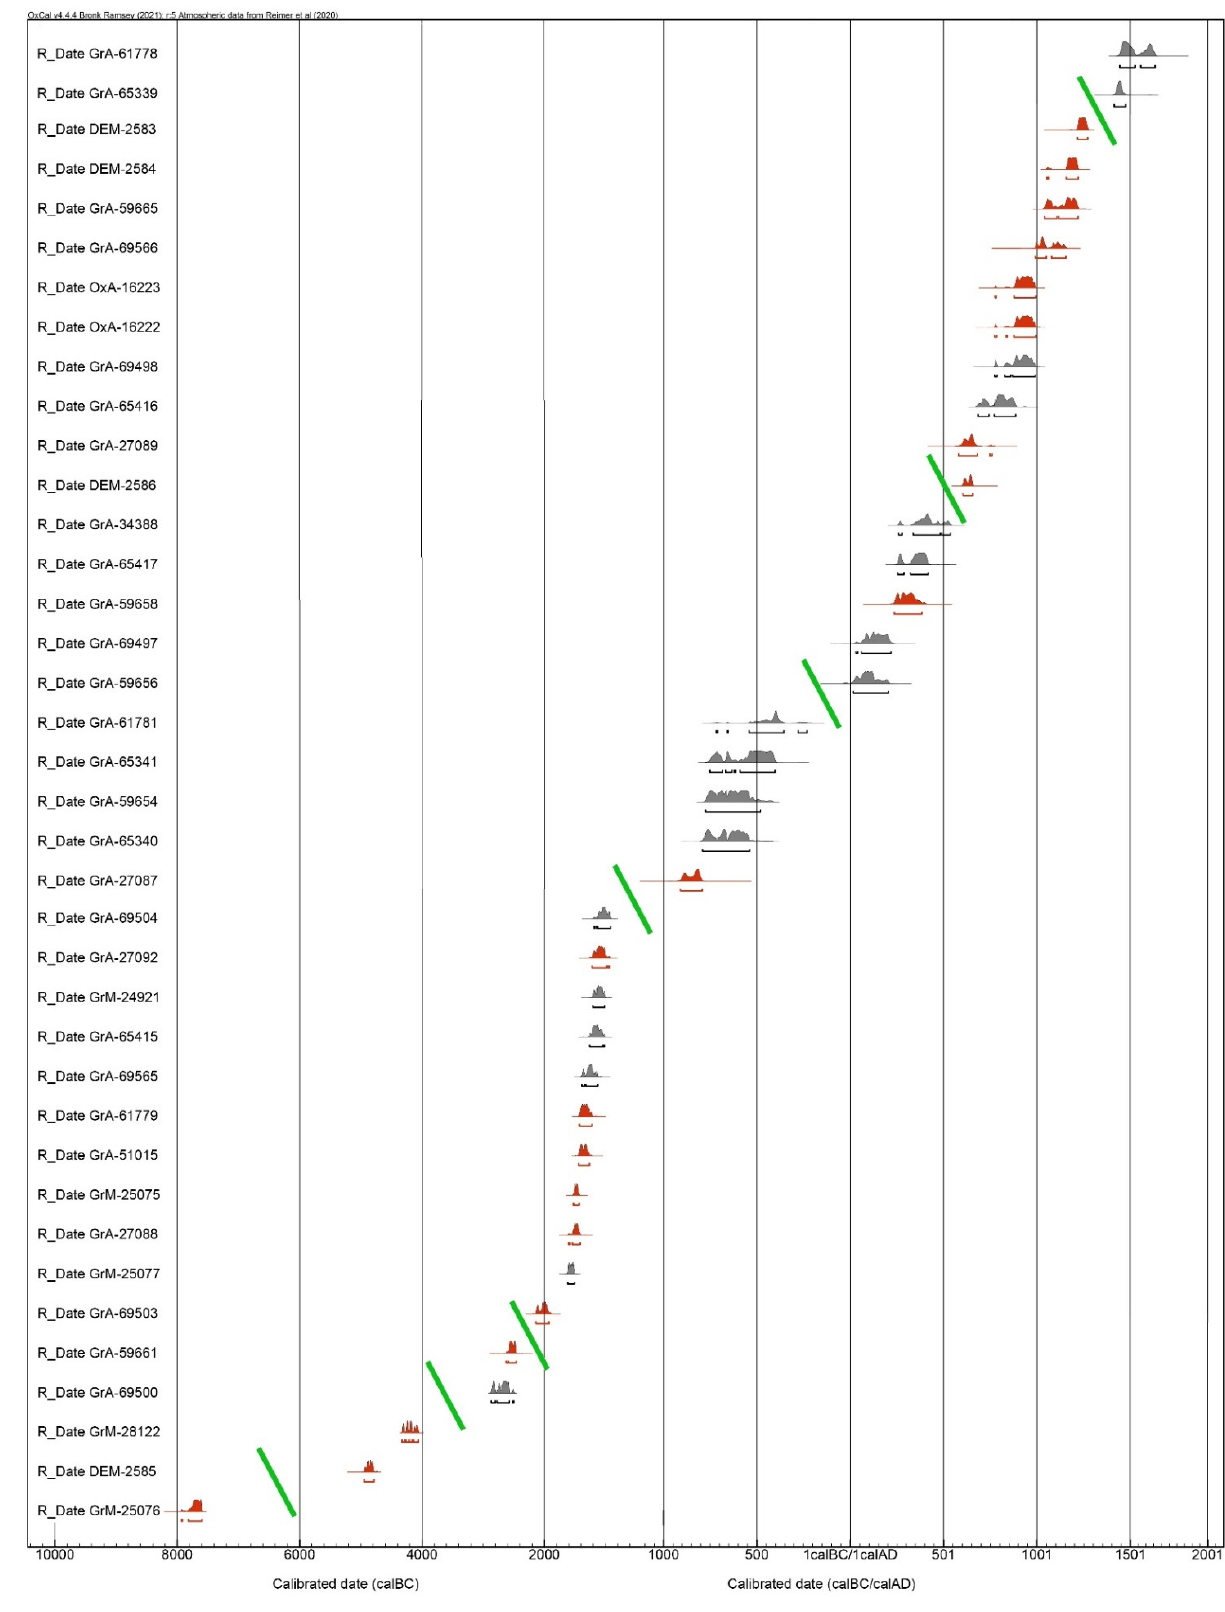
Figure 3. Plot of all the calibrated dates from the Samarina highlands. Grey histograms: HC tree-pits, red histograms: archaeological sites. The oblique green bars mark the discontinuity between different periods. Calibrations according to OxCal 4.4 [26].